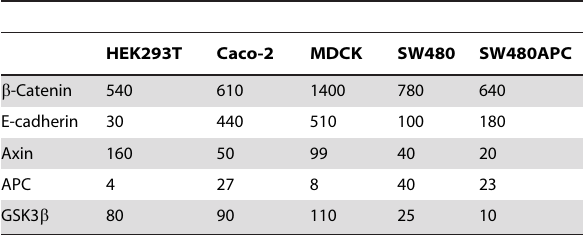
Table 4. Molecules per cell count ( 6